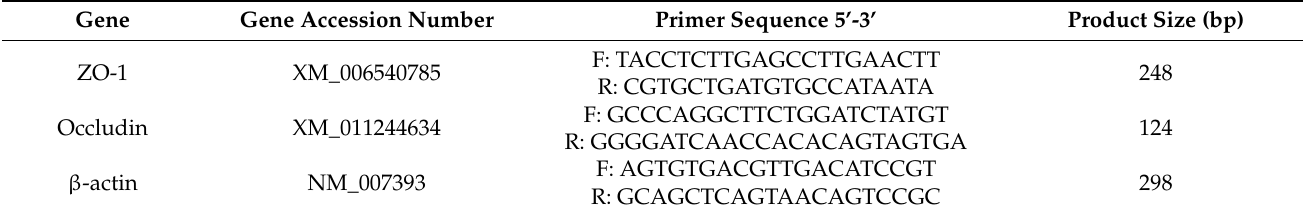
Table 1. Primers of target genes for